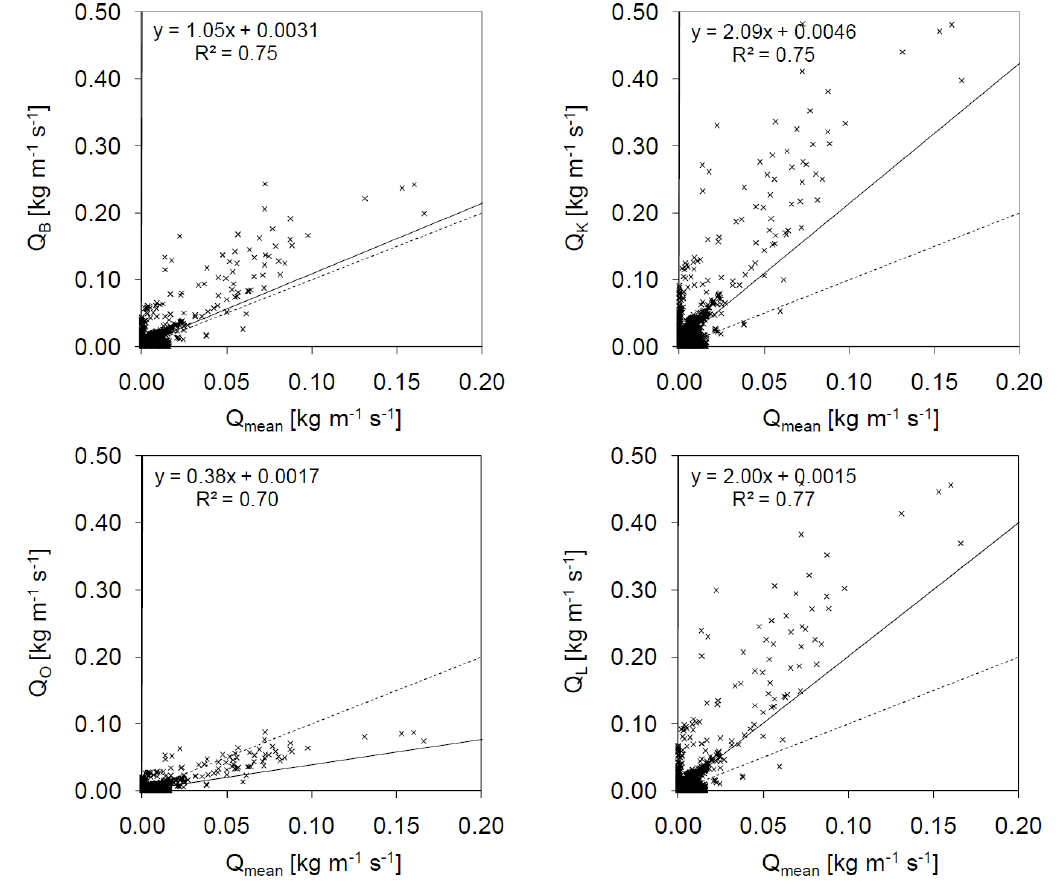
Figure 7. Comparison of Q the equations given in the text, when n ≠ 0 or u without rainfall. The solid line is the linear regression line. The dashed line is the line that would be obtained in case of perfect